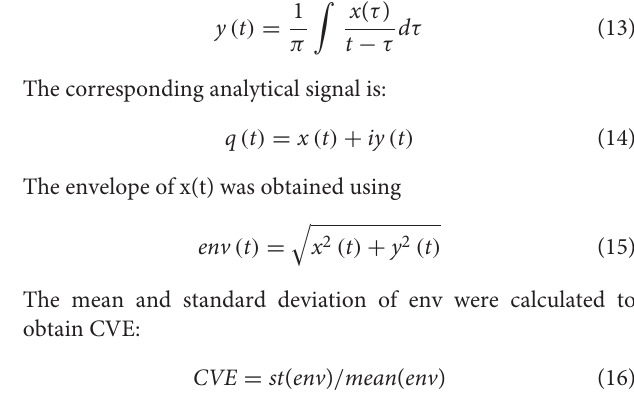
FIGURE 3 | Properties of IMFs derived from white noise. (A) An IMF component of white noise. (B) The probability distribution function (PDF) of amplitude follows a normal distribution. (C) Skewness for 10 5 simulated noise epochs is calculated and distributions were determined. The dashed lines at 95% confidence interval. (D) Kurtosis for 10 5 simulated noise epochs is calculated and distributions were determined. The dashed lines at 2.8 and 3.2 depict the 95% confidence